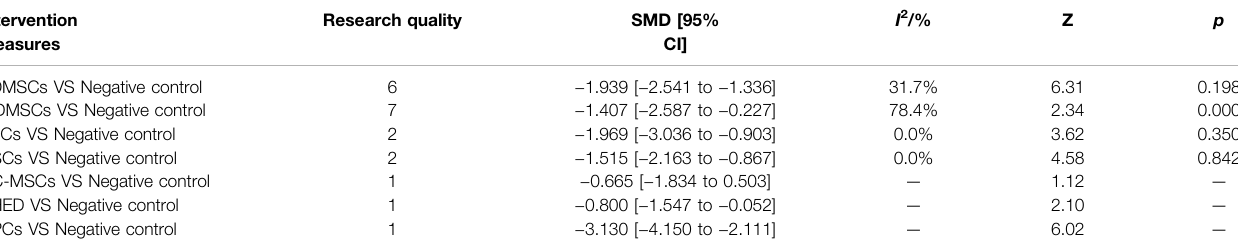
Research quality SMD [95%